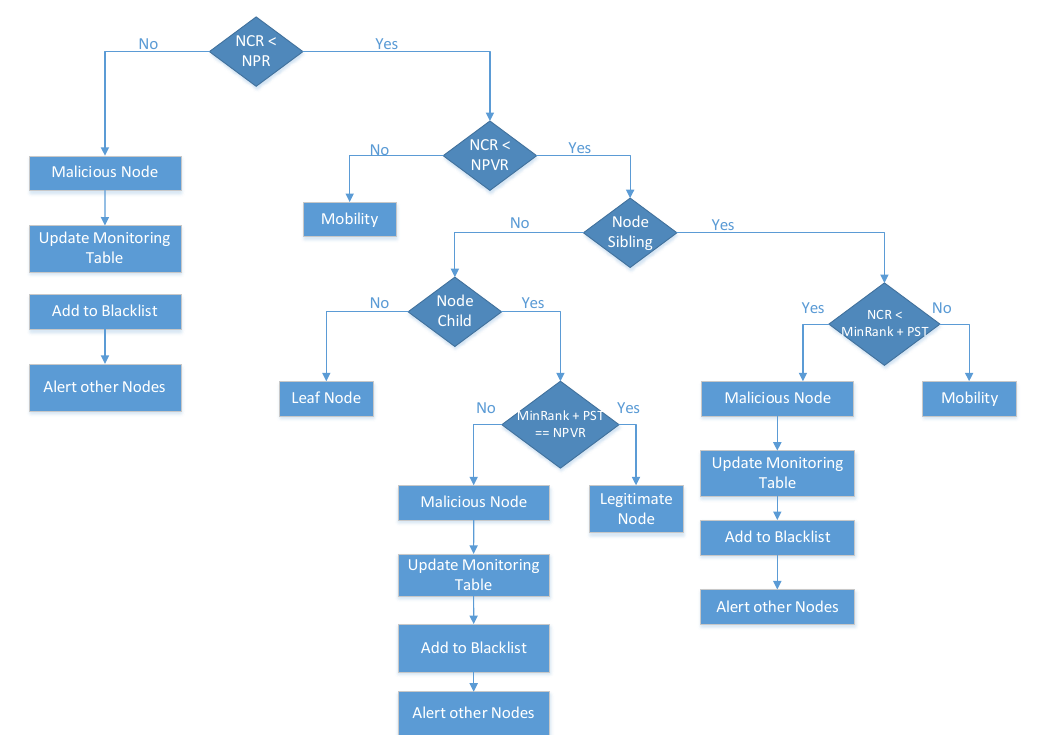
Figure 1. Protocol Model Flowchart, Phase Four.